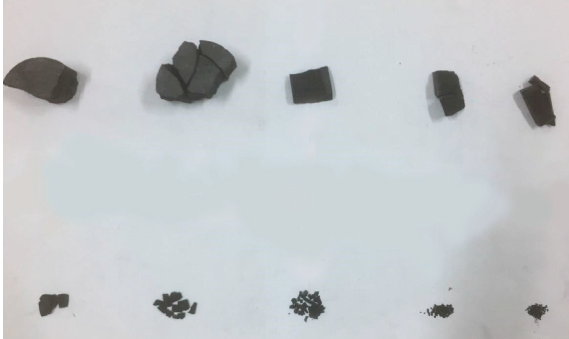
Figure 9: Examples of the shale sample after screening.